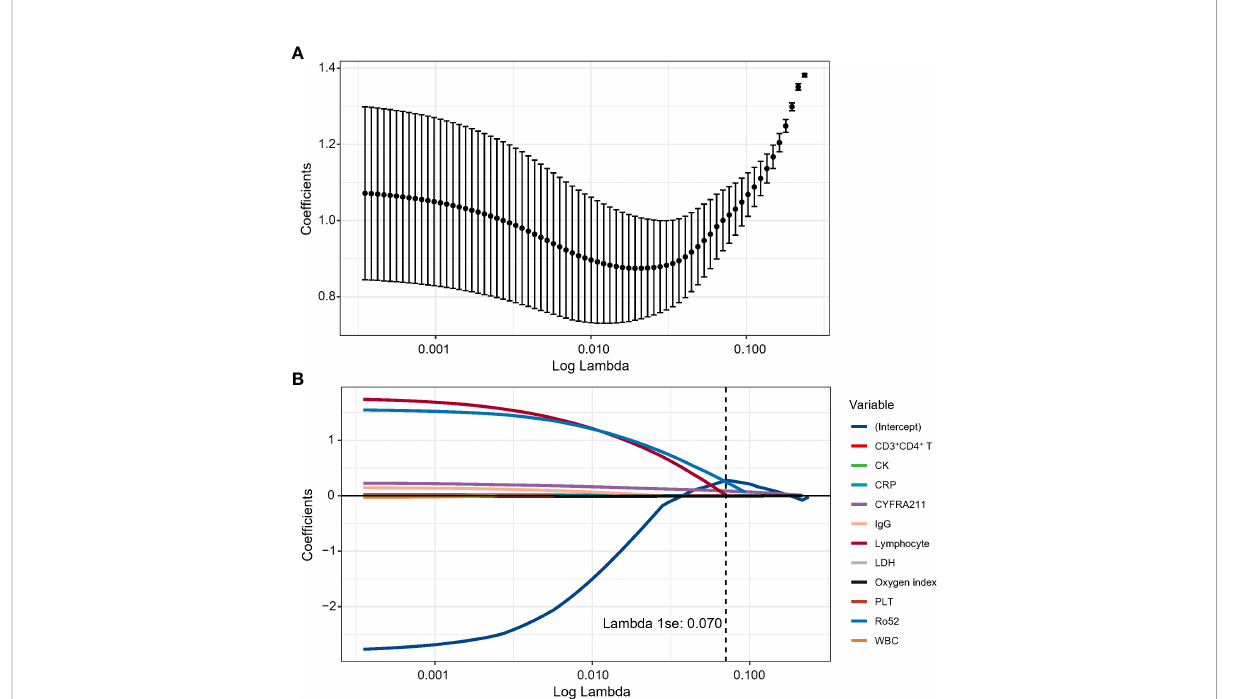
FIGURE 1 The optimal features were selected using a LASSO logistics regression. (A) Tuning parameter lambda selection in the LASSO method using 10- fold cross-validation via lambda.1se criteria in the discovery cohort. (B) LASSO coef fi cient pro fi les of the candidate blood